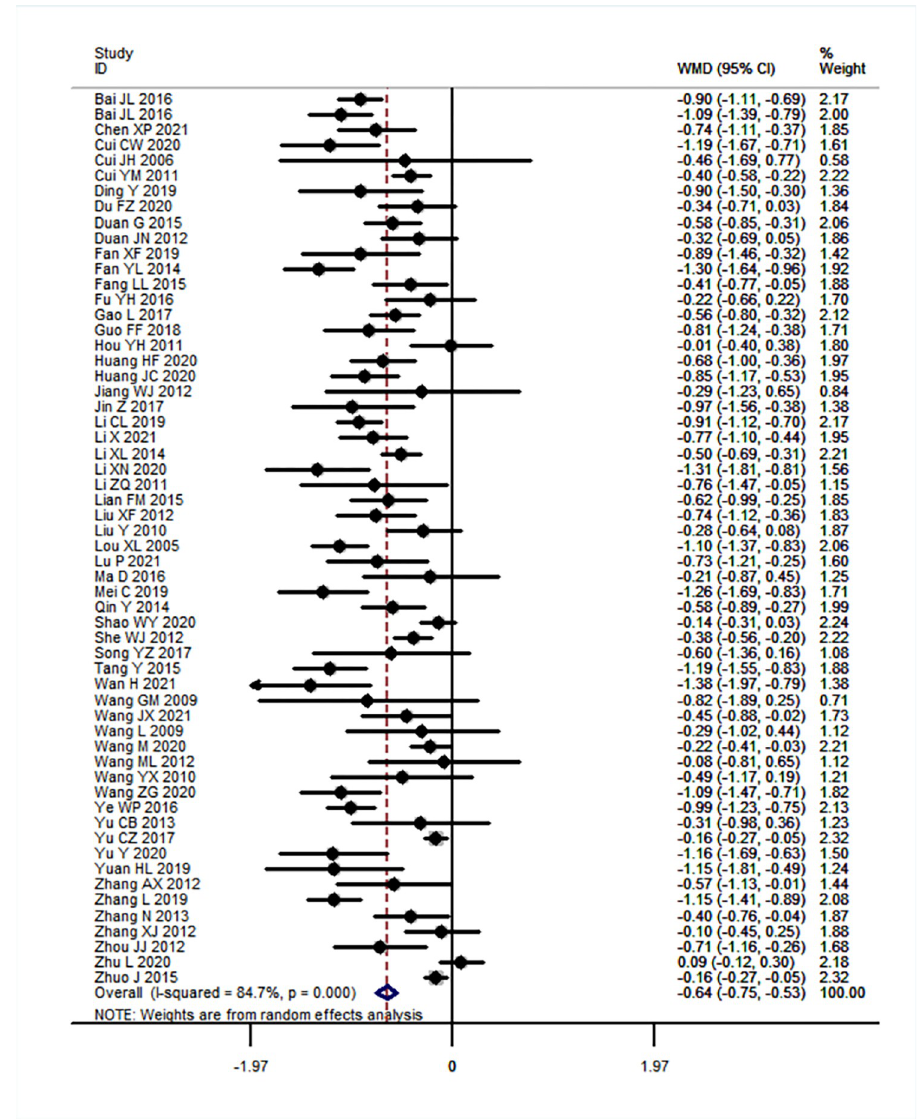
Fig 4. Forest plot of hemoglobin A1c level at end of treatment, Fuling formulae plus hypoglycaemic agents versus hypoglycaemic agents alone, results of